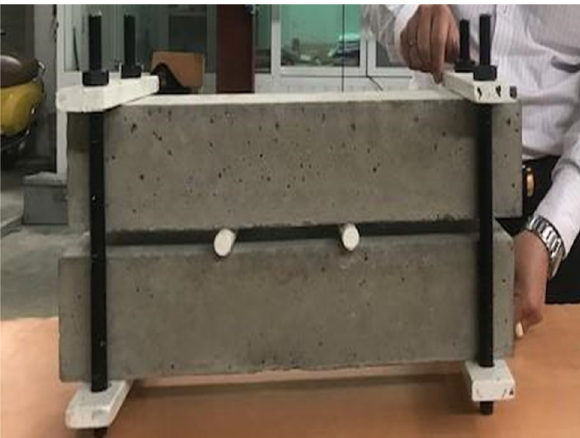
Figure 6: Arrangement for the loaded beam using a steel frame.